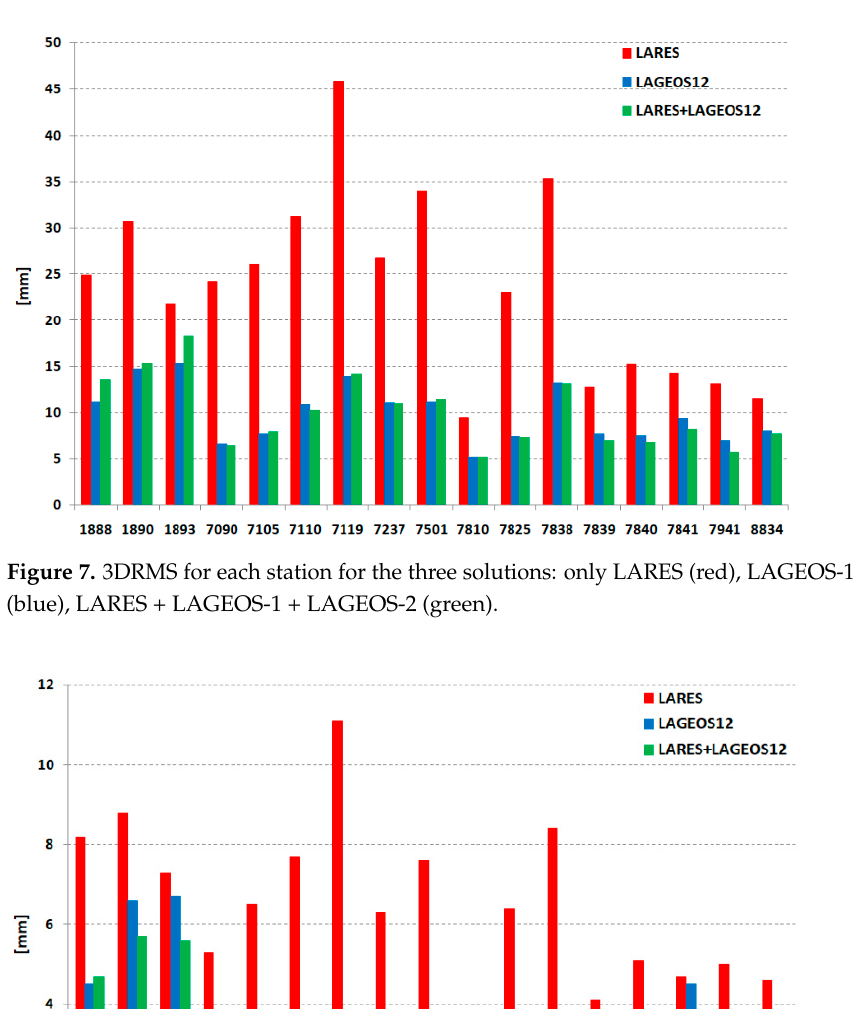
Figure 7. 3DRMS for each station for the three solutions: only LARES (red), LAGEOS-1 + LAGE- OS-2 (blue), LARES + LAGEOS-1 + LAGEOS-2 (green). alone, mainly because it features a much higher number of normal points.